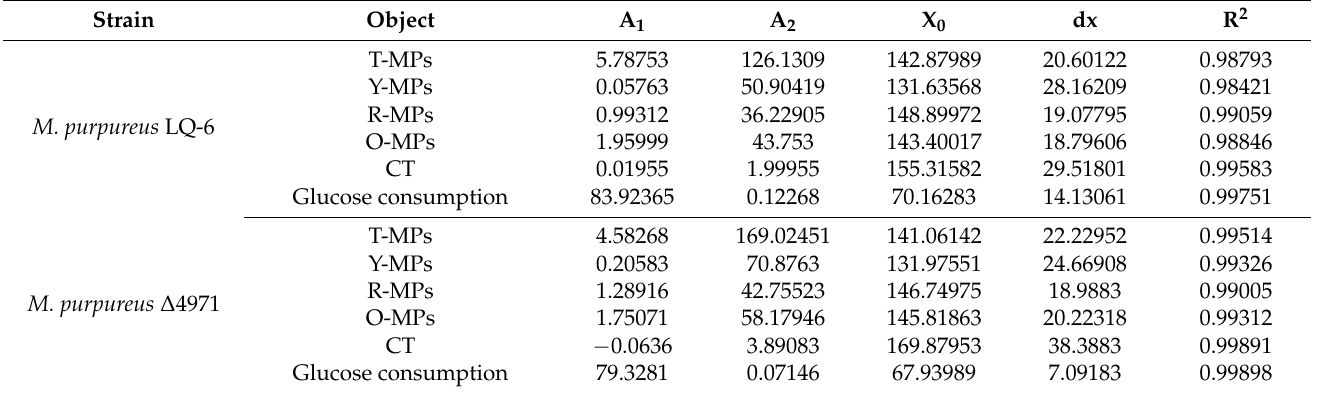
Table 2. Boltzmann Fitting equations and the correlation coefficient R 2 of fermentation kinetics of M. purpureus ∆ 4971 and